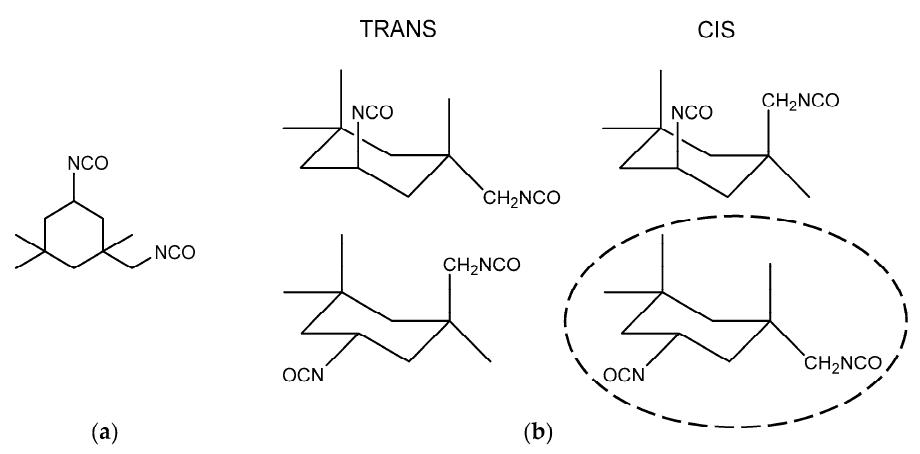
Figure 5. Structure of ( a ) IPDI and ( b ) four isomers of IPDI.